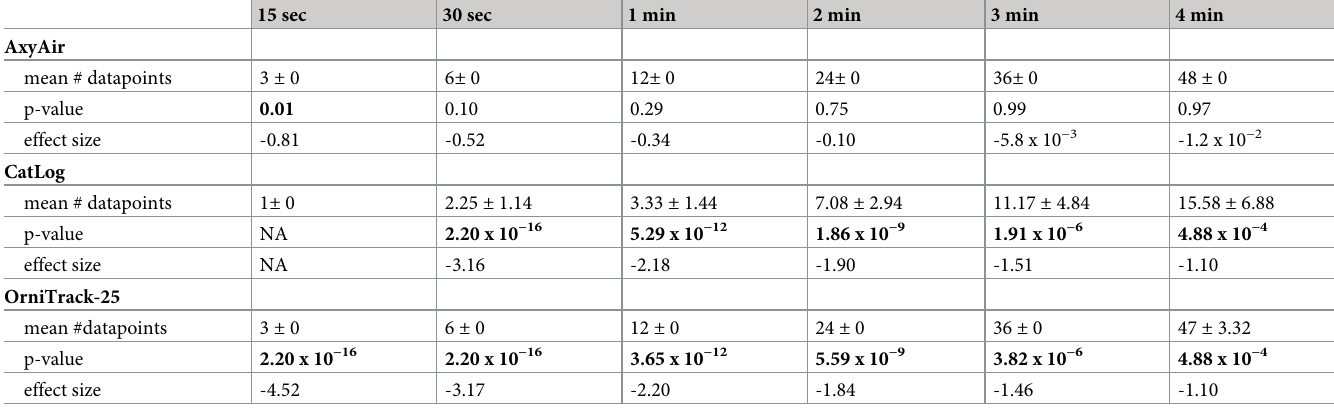
Fig 4. Mean difference between the altitude estimate of each device type and laser altimeter during horizontal movements. Asterisks represent significant differences from the laser altimeter ( α � 0.05). https://doi.org/10.1371/journal.pone.0276098.g004 For the CatLog device, PDOP values were only available for the last 7 (out of 10) of the flights due to a change in CatLog units beginning on flight number 4 (as above). Filtering out datapoints with PDOP values > 2 removed 3 entire flights from further analysis and an addi- tional 3.5% of data points from remaining flights. When points with PDOP > 2 were removed, the mean altitude estimates of remaining points were still much greater than the laser altimeter (S7 Fig) and did not improve overall accuracy, however we were not able to perform a statisti- cal test to assess accuracy due to the low sample size (n = 4) that resulted from removing PDOP values > 2. When datapoints with HDOP values > 2 were removed from the analysis, this removed 5 entire flights from further analysis for the CatLog device (F25, F27, F28, F29, F35) and 0% of points from remaining flights; it removed no flights or points for the Table 1. P-values of one-sample Wilcoxon signed-rank tests to evaluate if the difference between the estimated altitude of each device and laser altimeter differed from zero within different time intervals during horizontal movements. CatLog did not take consistently take points every 15 seconds, therefore datapoints could not be sorted in 15 second time intervals. Effect size was provided by the ‘lmerTest’ output in R. Significant differences are in bold ( α �